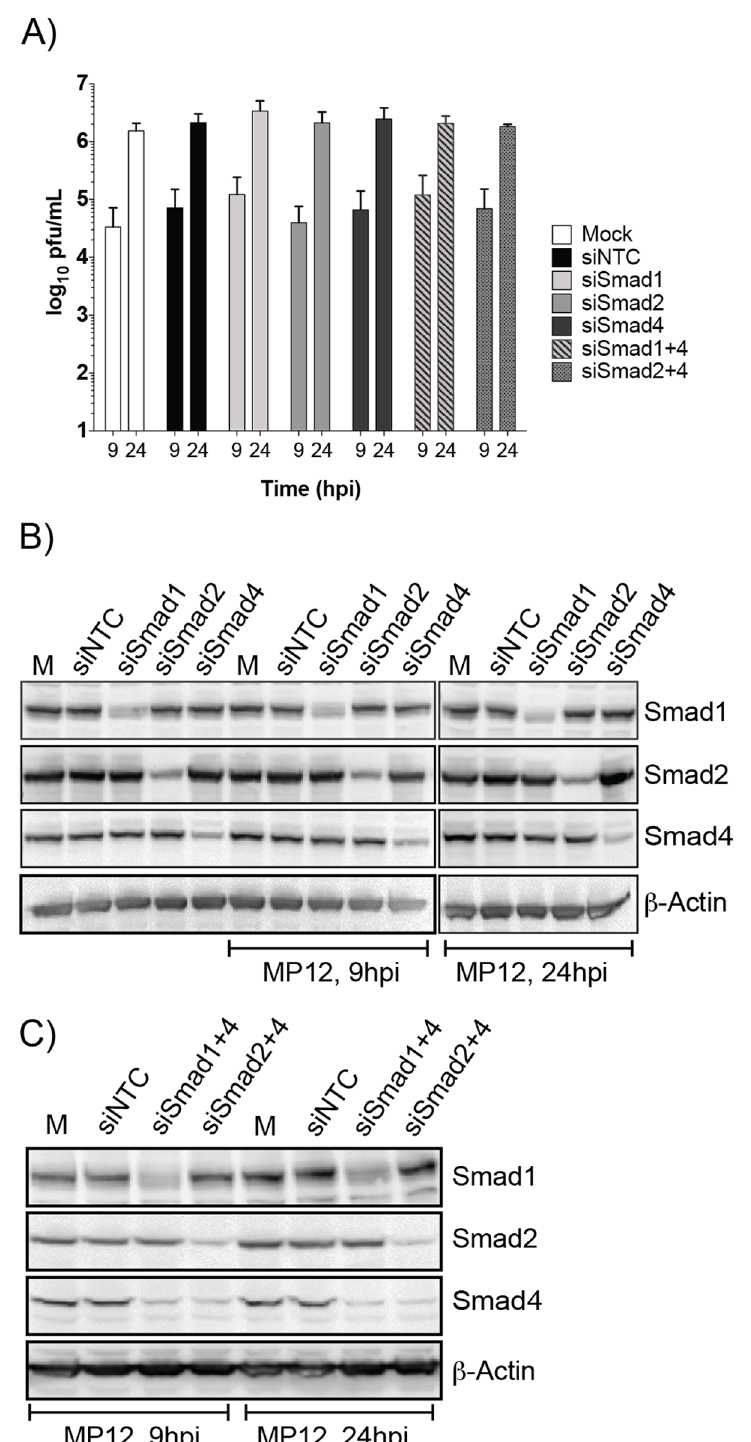
Fig 4. siRNA knockdown of Smad1, -2 and 4 does not impact RVFV replication. HSAECs transfected with media alone (Mock) or siRNAs (75nM) directed against a nontargeting control (NTC), Smad1, -2, or -4 were infected with MP12 virus (MOI 0.1). Both extracellular media supernatants (A) and protein lysates (B,C) were harvested at 9 and 24hpi. A) Infectious viral titers were determined by plaque assay. Data plotted as a bar graph of the mean with standard deviation of four replicates. Protein lysates from single (B) and double knockdowns (C) were analyzed by western blot for actin, total Smad1, -2, and -4 expression.